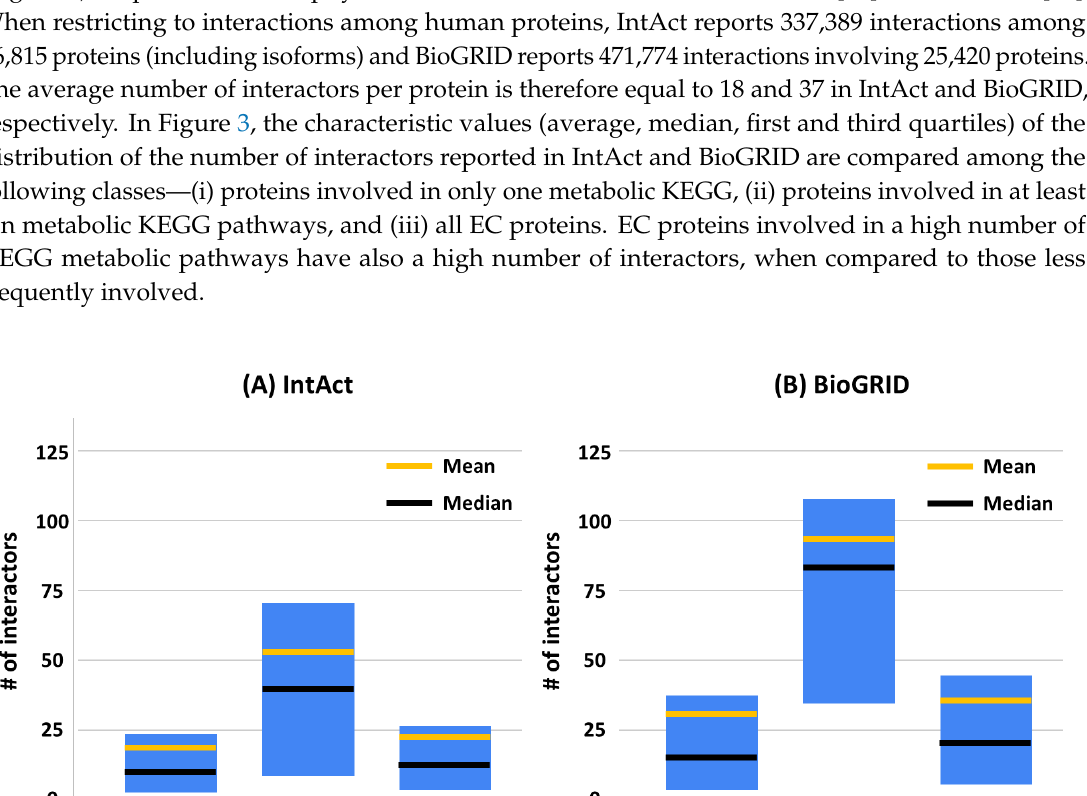
Figure 4. Statistical characterization of the number of interaction sites predicted with ISPRED4 in EC proteins associated with only one or at least 10 metabolic pathways. For each set, the boxes represent the first and third quartiles; yellow and black lines represent mean and median values, respectively. Significance of the reported difference on median values has been validated using the Mann–Whitney U test obtaining p -value = 0.04. # Number of. For the human EC proteins that most frequently (≥10 times) participate in KEGG metabolic pathways, Table 3 lists details including the most representative PDB structure (highest coverage to the protein sequence (≥70%) and highest atomic resolution). For each EC protein, we also indicate the